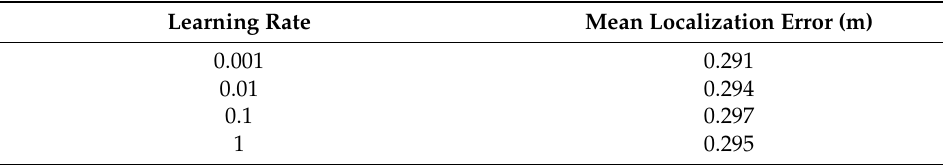
Figure 6. Minimum mean localization error values for the used learning rates. Table 1. Average mean localization error (m) for used learning rates.